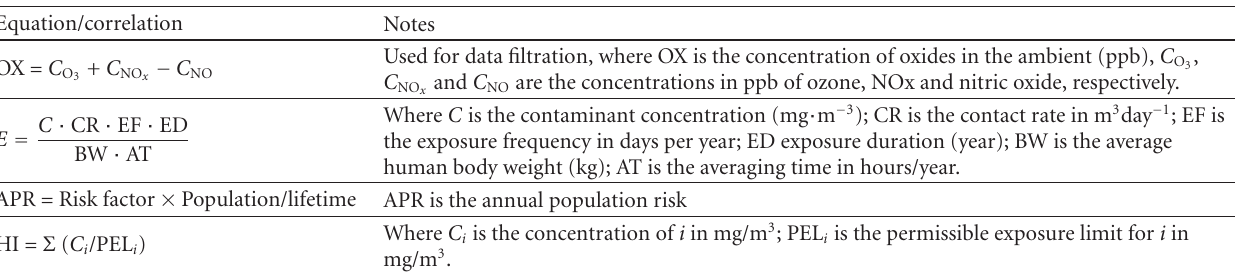
Table 1: Standard USEPA methodology for annual population risk (APR) and hazard index (HI) calculations used by Al-Salem